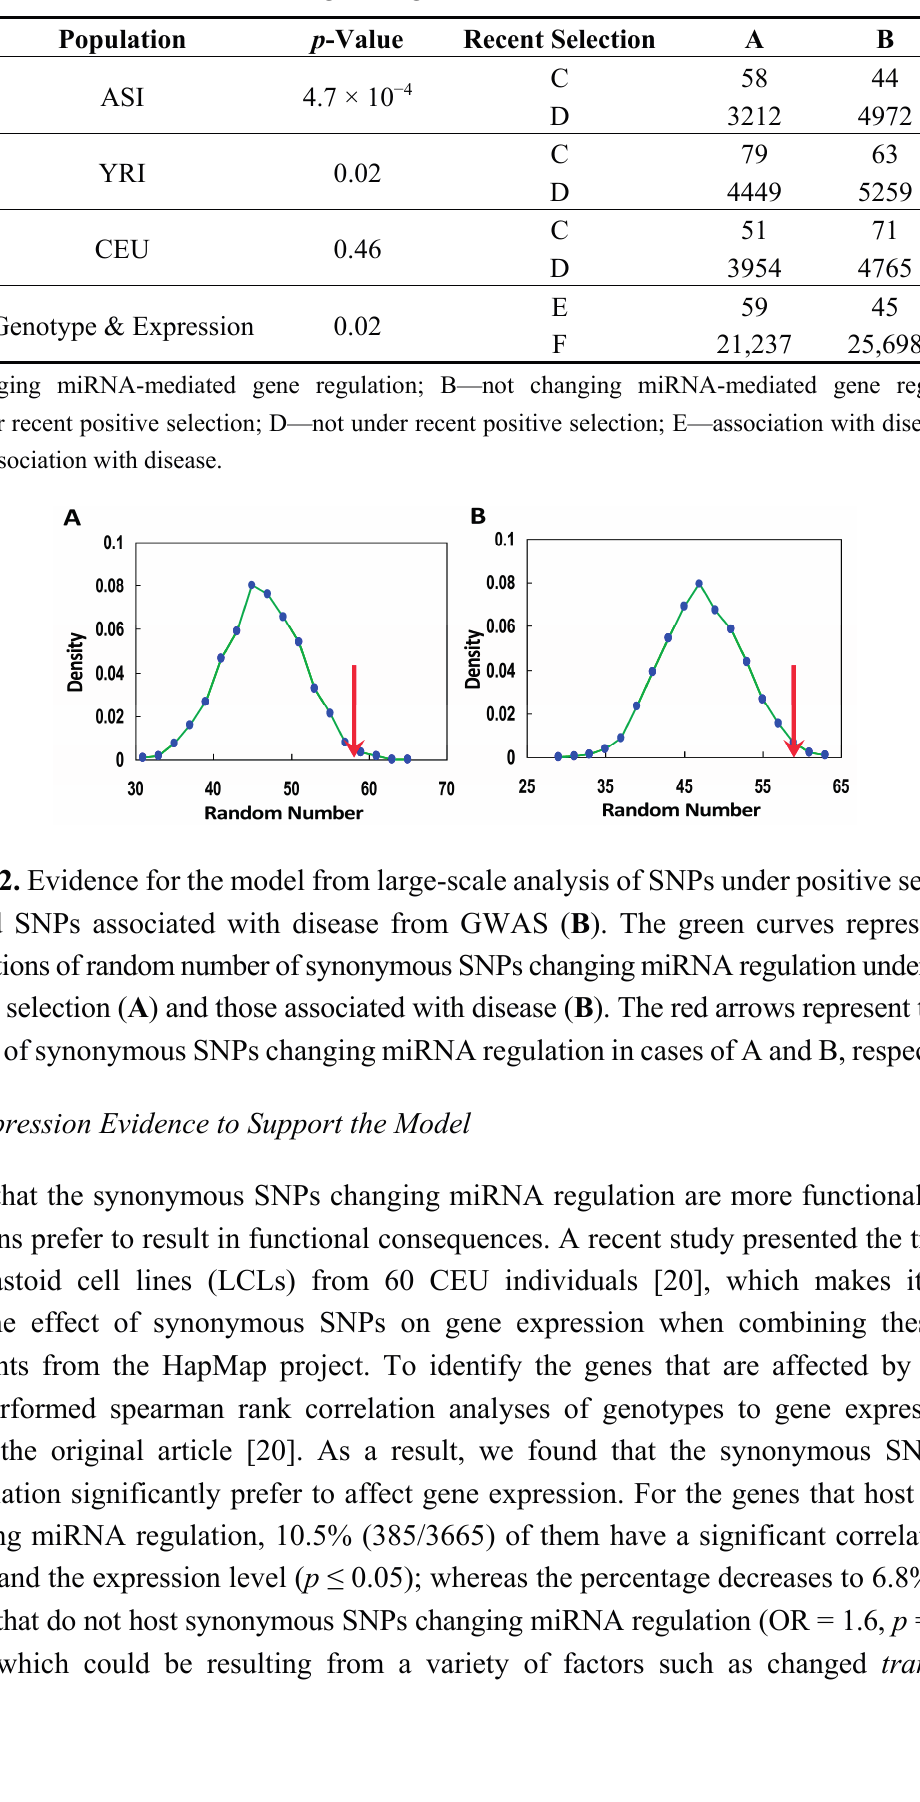
Table 1. Statistics of synonymous SNPs in the context of recent positive selection, gene expression, and miRNA-mediated gene regulation.